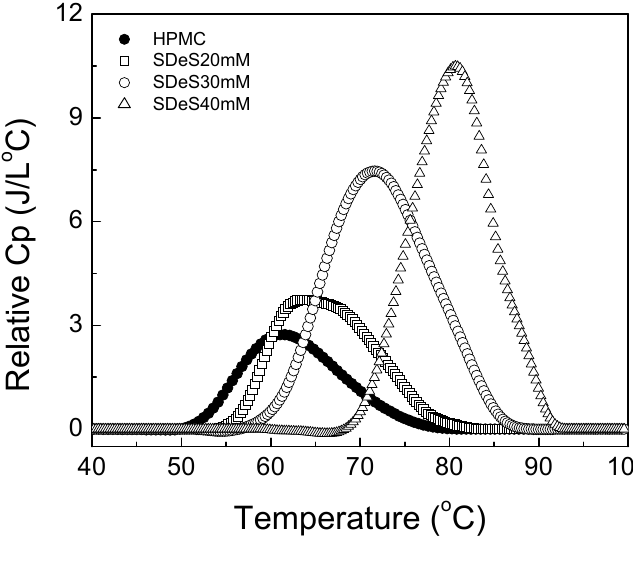
Figure 11. Relative heat capacity as a function of temperature for 1 wt% HPMC solutions with different concentrations of sodium n-decyl sulfate